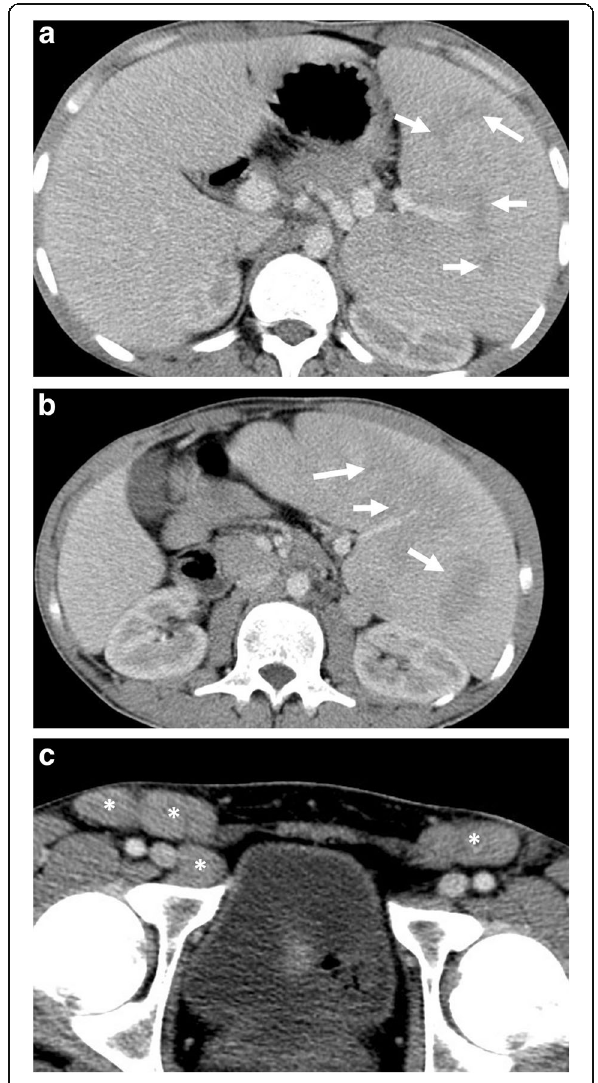
Fig. 16 A 21-old man was admitted to the emergency department with a 2-week history of left upper quadrant abdominal pain and fever. Physical examination revealed splenomegaly and inguinal lymphadenopathy. Increased serum levels of acute-phase reactants, leukocytosis, and high sedimentation were evident at blood analysis. a , c Axial contrast-enhanced portal venous phase CT images demonstrate patchy areas of hypoattenuation (arrows, a , b ) within the enlarged spleen and bilateral inguinal lymphadenopathy (asterisks, c ). The liver was normal except for mild hepatomegaly (18 cm). The diagnosis of Leishmaniasis was made by histopathological examination following